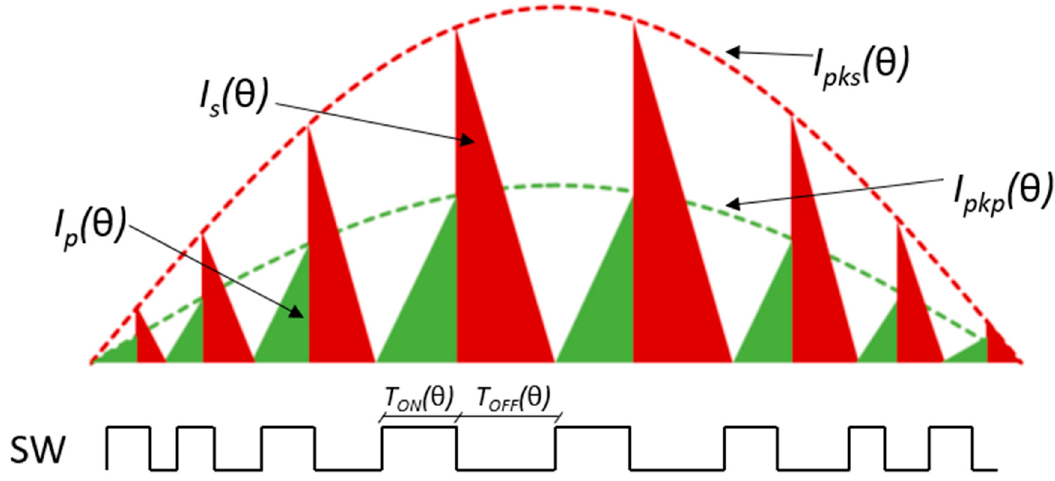
Figure 9. Primary and secondary currents in a QR-controlled Hi-PF flyback converter.